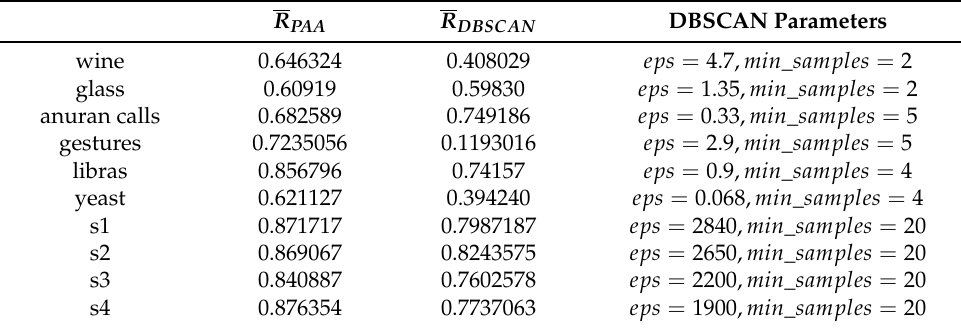
Table 4. Values of Rand index for PAA and